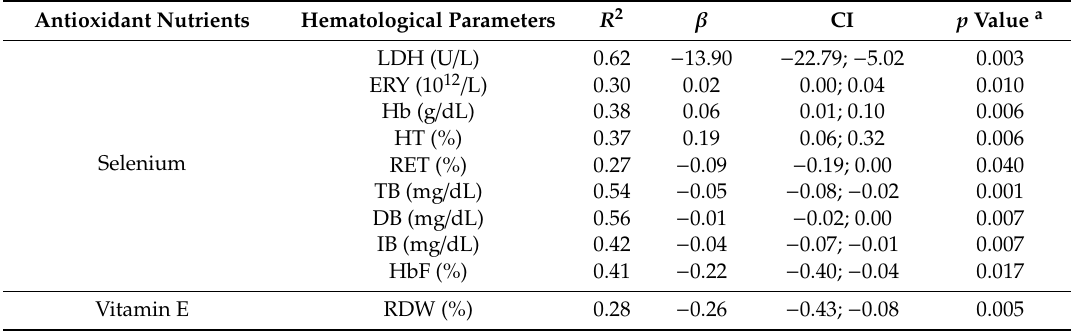
Table 4. Final model between nutrients and hematological parameters in adult sickle cell disease patients ( n = 51).